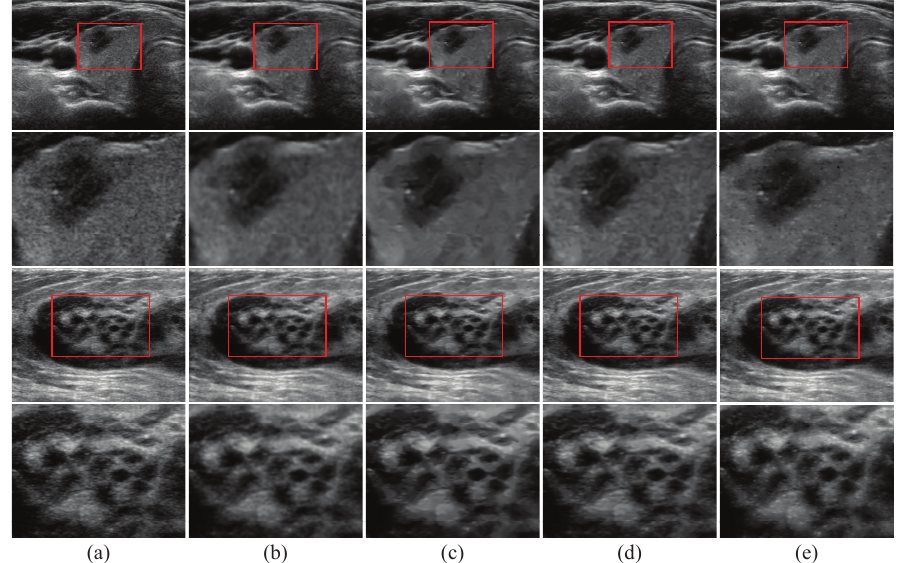
Figure 6. Comparison of despeckling results on the thyroid and breast ultrasound images. ( a ) The original thyroid and breast ultrasound images and the results by ( b ) bilateral filter [6], ( c ) OBNLM [29], ( d ) the method of Zhu et al. [14], and ( e ) the proposed method. The first and third rows list the full-size images, and the second and fourth rows show the zoomed-in patches containing the regions of interest (ROIs), marked by the red rectangles in the whole images.